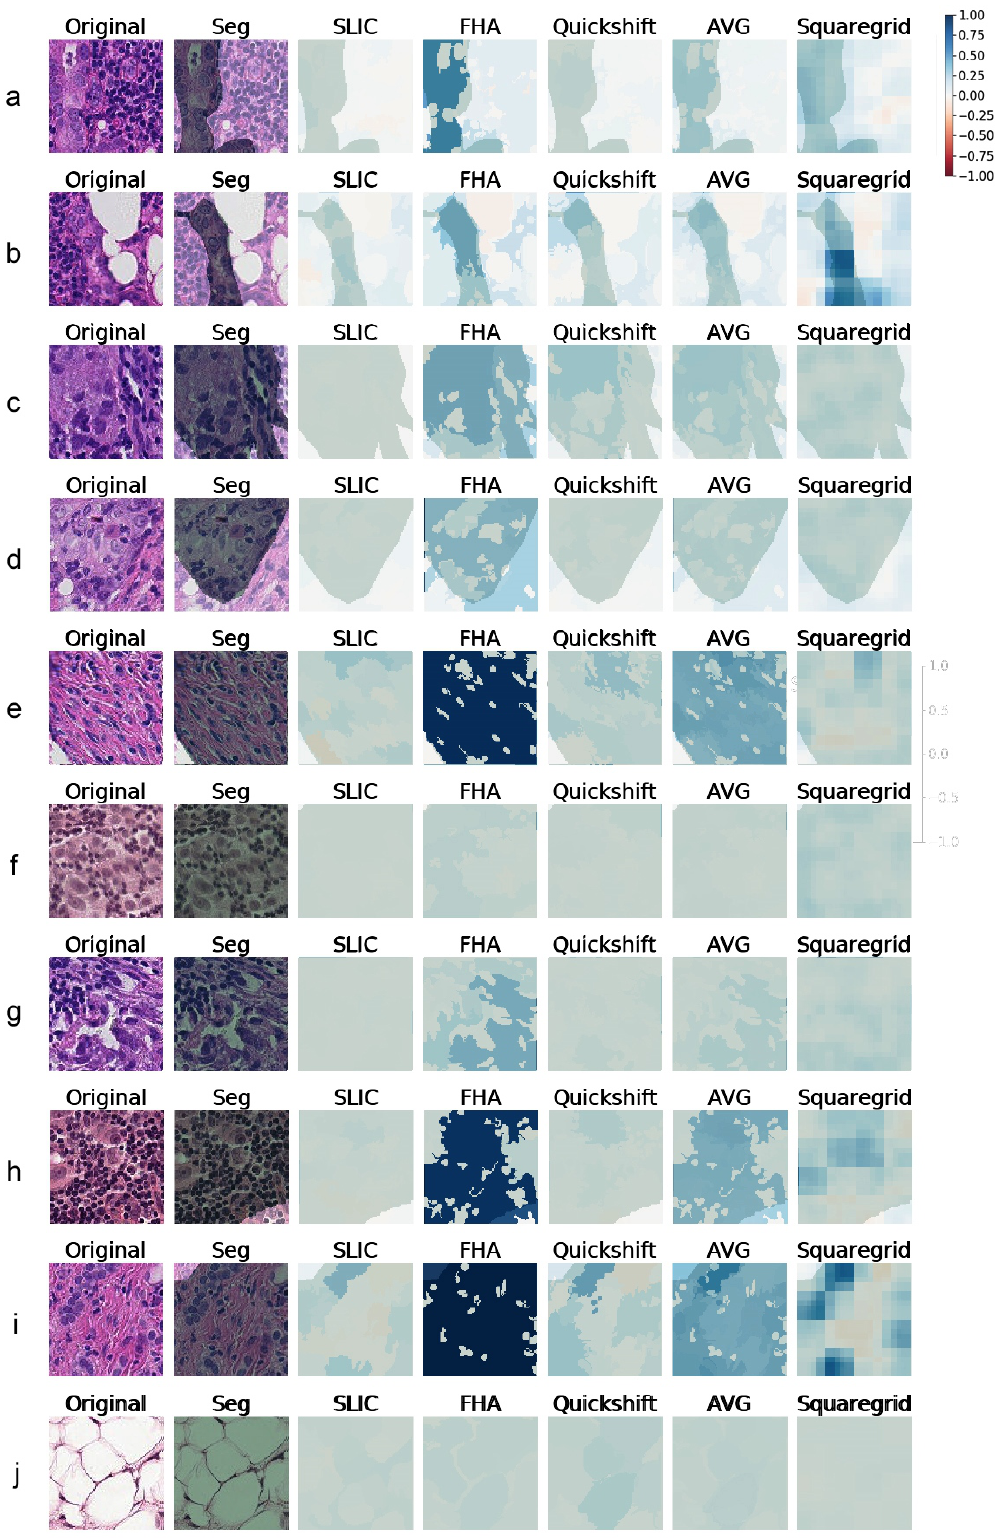
Figure 7. ( a – j ) Explanations generated for several images correctly predicted as Class 1 (true positives) by VGG19. Medical Segmentation (Seg) in transparent green. The color scheme is the same used in Figure